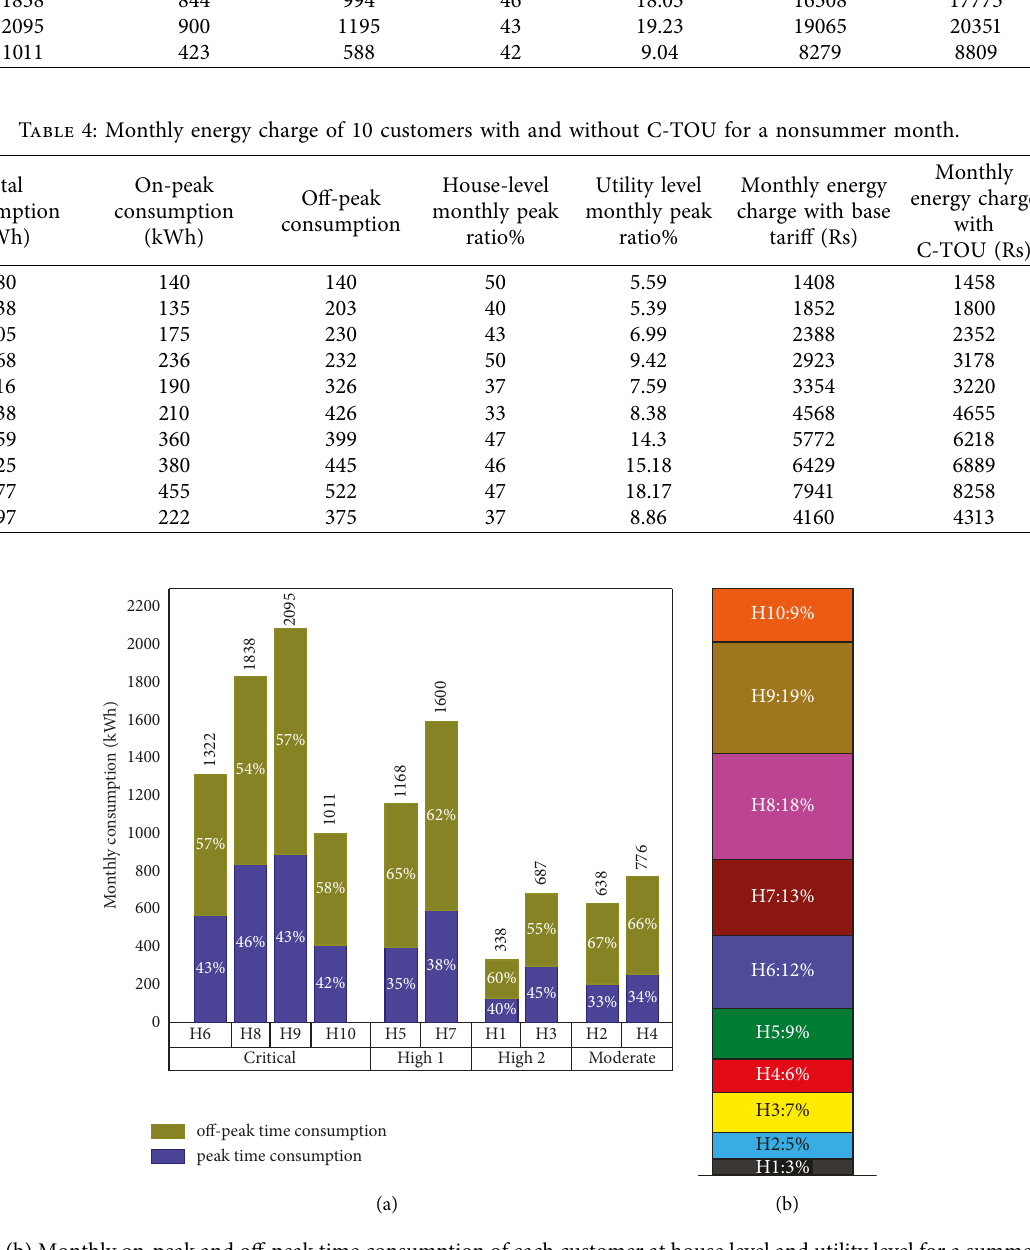
Figure 10: (a), (b) Monthly on-peak and off-peak time consumption of each customer at house level and utility level for a summer month.